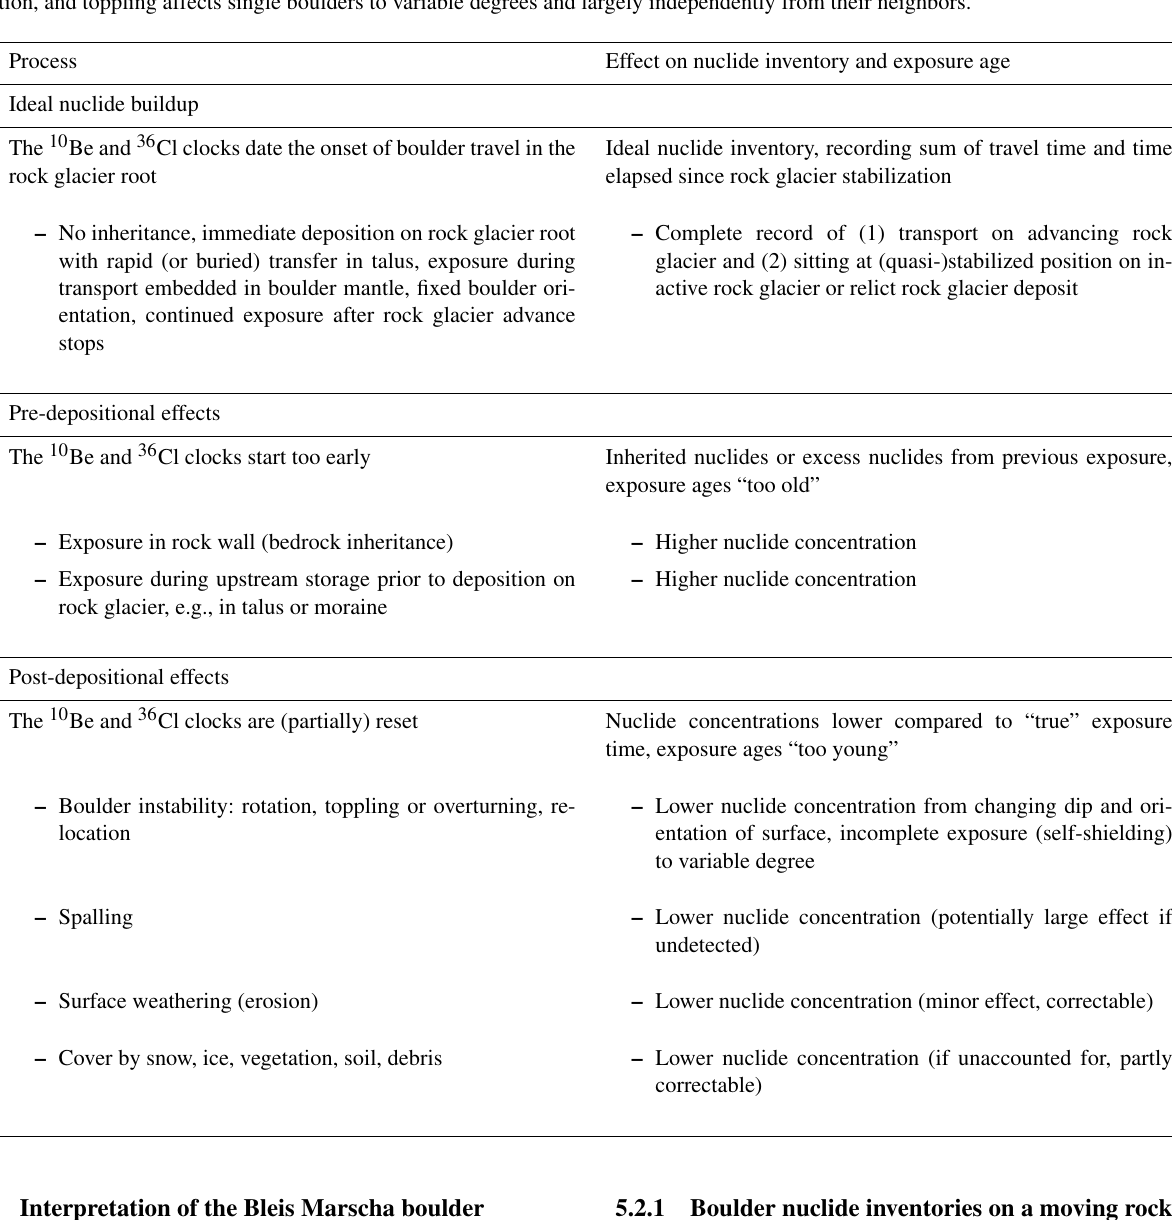
Table 4. Processes that affect measured cosmogenic nuclide concentration in a boulder on an active rock glacier (see text for discussion). Surface processes like exposure in the bedrock (inheritance), post-depositional weathering, spalling, unaccounted for cover or shielding, rotation, and toppling affects single boulders to variable degrees and largely independently from their